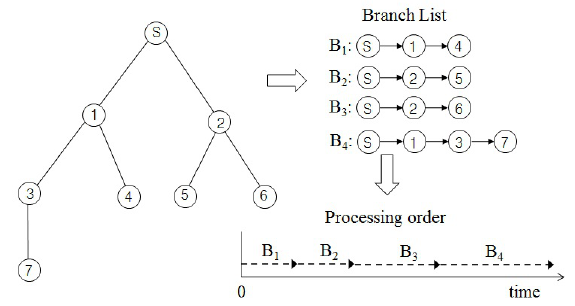
Figure 4. Generating and processing branches.